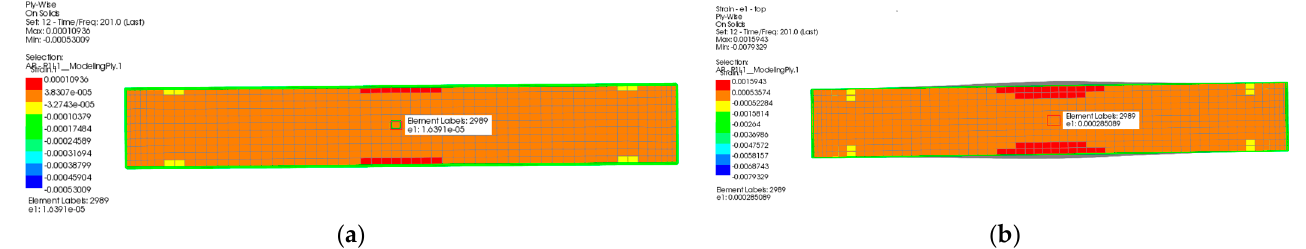
Figure A6. Three ‐ point bending test FEA results related to Section 3: ( a ) strain in the x ‐ direction for the simulated beam under 435N loading, and ( b ) strain in the x ‐ direction for the simulated beam under 4024N loading.